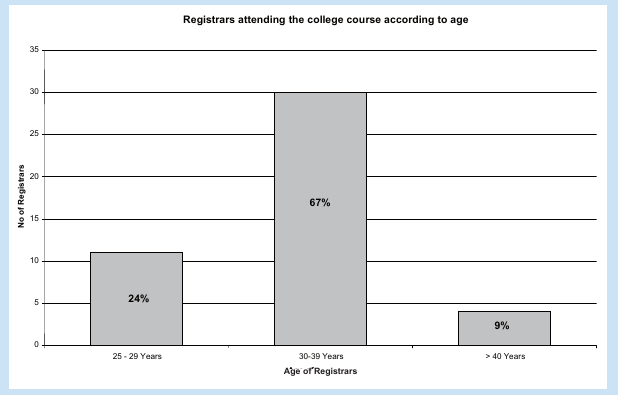
Percentageofregistrarsinvolvedinresearch/publicationpre-registrarship